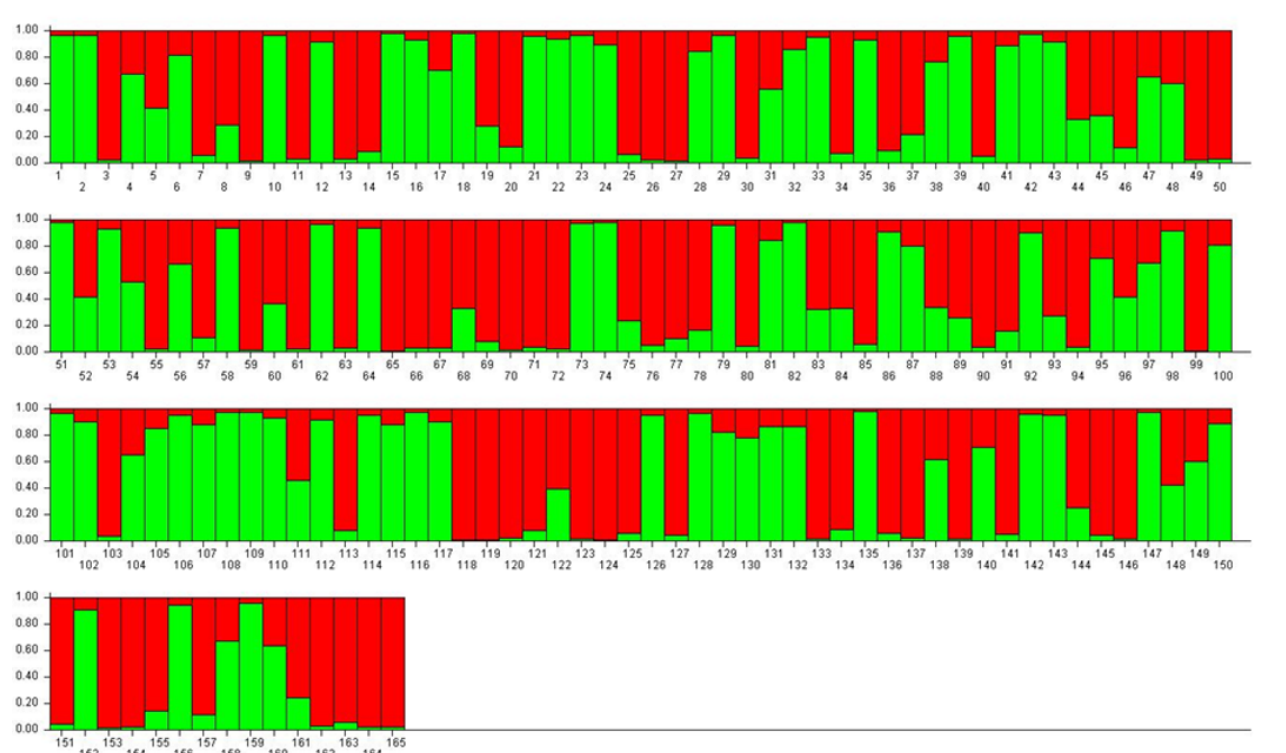
Figure 2. Bar plot of the results from a Bayesian genetic structure analysis with K = 2, green RPP2:1, red RPP2:2. For accession names, see Supplementary Table 1.